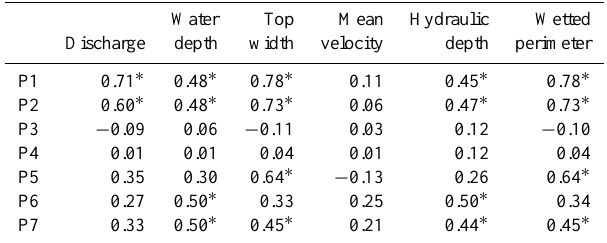
Table 2. Pearson cross correlation among the basins’ descriptors. Table 3. Pearson cross correlation between basin descriptors and cross sectional hydraulic parameters based on the calibration